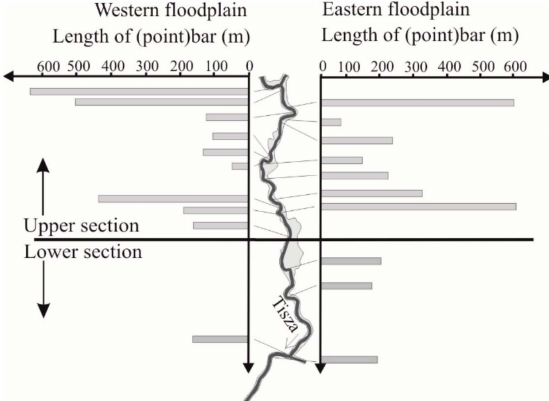
Figure 4. Location and length of active bars.